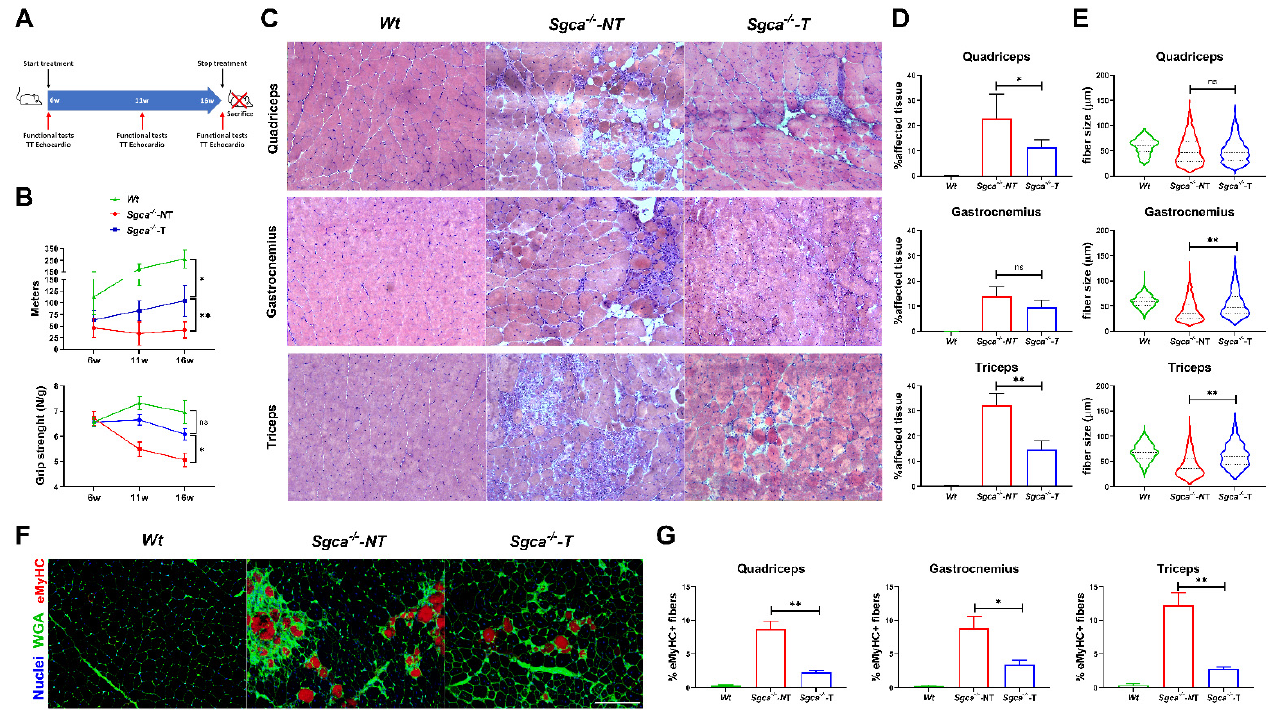
Figure 1. Effect of nintedanib on muscle function and architecture. ( A ) Scheme of the experimental design and the treatment of mice with nintedanib. ( B ) Results of the muscle functional tests at the different time points. Top panel, treadmill test showing a significant improvement of the covered distance of Sgca -/- -T compared to Sgca -/- -NT. Bottom panel, grip strength test showing that muscle strength significantly improved after treatment with nintedanib. ( C ) Representative pictures of the hematoxylin and eosin (H-E) staining of muscle sections from quadriceps, gastrocnemius and triceps of all Wt , Sgca -/- -NT and Sgca -/- -T mice. ( D ) Histological assessment of the affected muscle tissue including muscle necrosis, fibrosis and inflammation in Wt , Sgca -/- -NT and Sgca -/- -T mice. ( E ) Cross- sectional muscle fiber area quantification in muscle sections from quadriceps, gastrocnemius and triceps. ( F , G ) Effect of nintedanib on the number of regenerating muscle fibers. Representative images of eMyHC staining are shown ( F ) and the percentage eMyHC positive fibers over total fibers are shown ( G ). TT: Transthoracic. Genetic background mouse strain C57BL ( Wt ); n = 6, no-treated Sgca -/- mice (Sgca -/- -NT), n = 14; nintedanib-treated Sgca -/- mice (Sgca -/- -T). Data are expressed as means ± SD. w = weeks; * p < 0.05 and ** p < 0.001. Scale bar = 200 µ m. ns indicates no significant